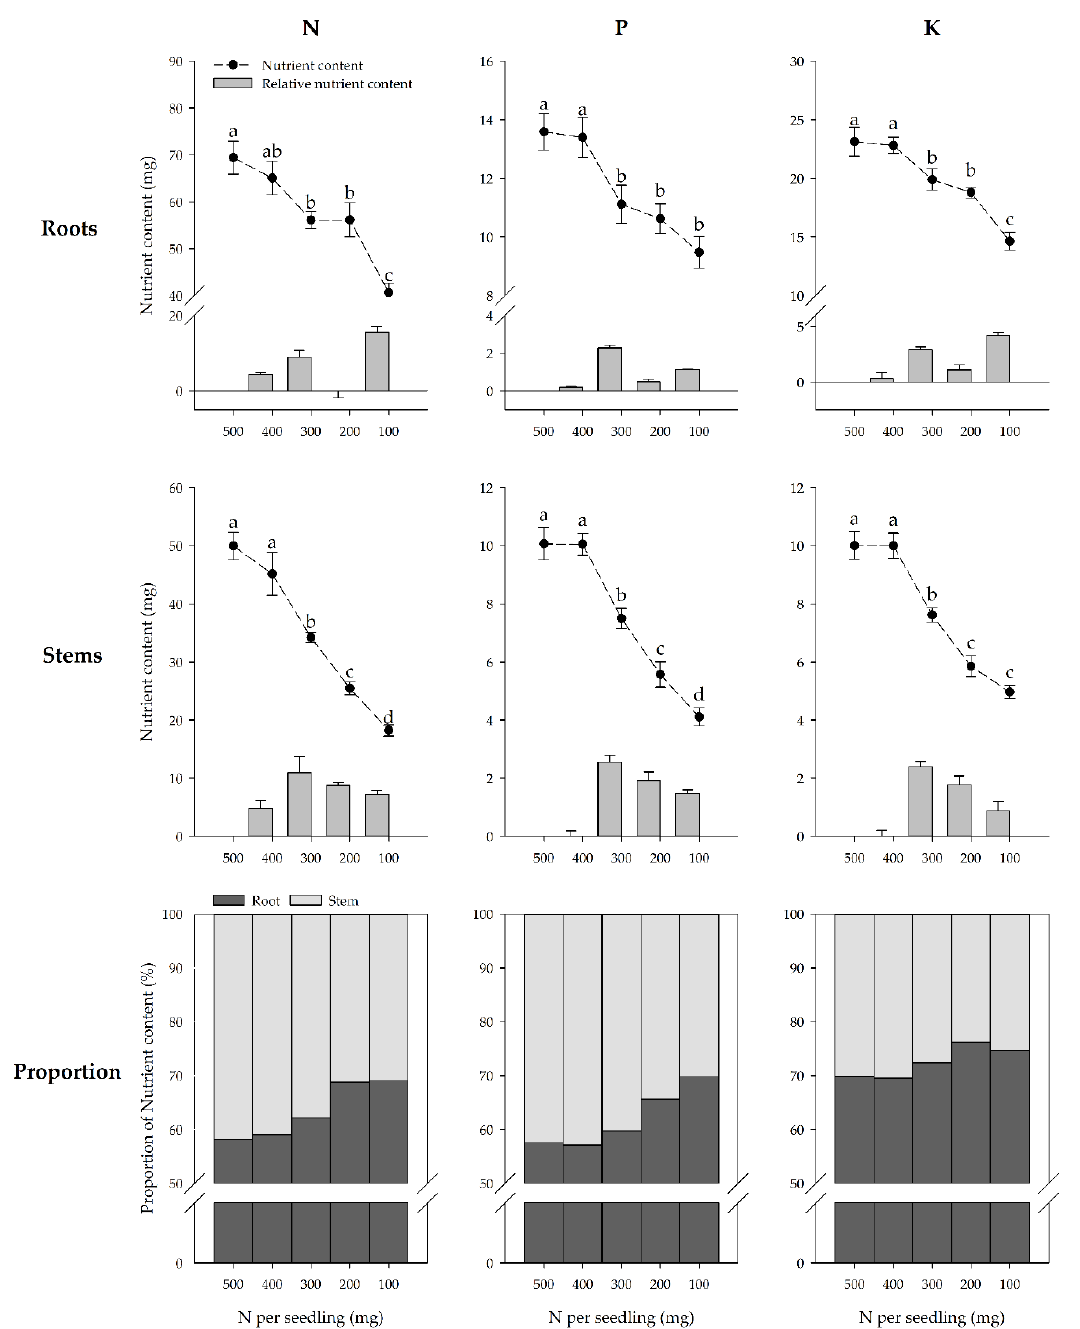
Figure 2. Nutrient content and nutrient content increment of the P. chinensis seedling roots and stems, and the nutrient content proportion of the roots or stems to the storage organs under specific nutrient treatment conditions at the end of the growing season. The nutrient content increment represents the N, P, or K content of the roots or stems that were reduced between two contiguous nutrient treatments. The mean and SE are shown for each nutrient treatment. Error bars with different letters differ statistically according to Duncan’s test at α = 0.05. The proportion of N, P, and K in the roots exceeded 50% under all nutrient treatments at the end of the growing season (Figure 2). The plants in the two highest nutrient treatments did not di ff er in their proportion of root N, P, and K content to total nutrient content. The highest proportion of N, P, and K in the roots occurred in the lowest nutrient